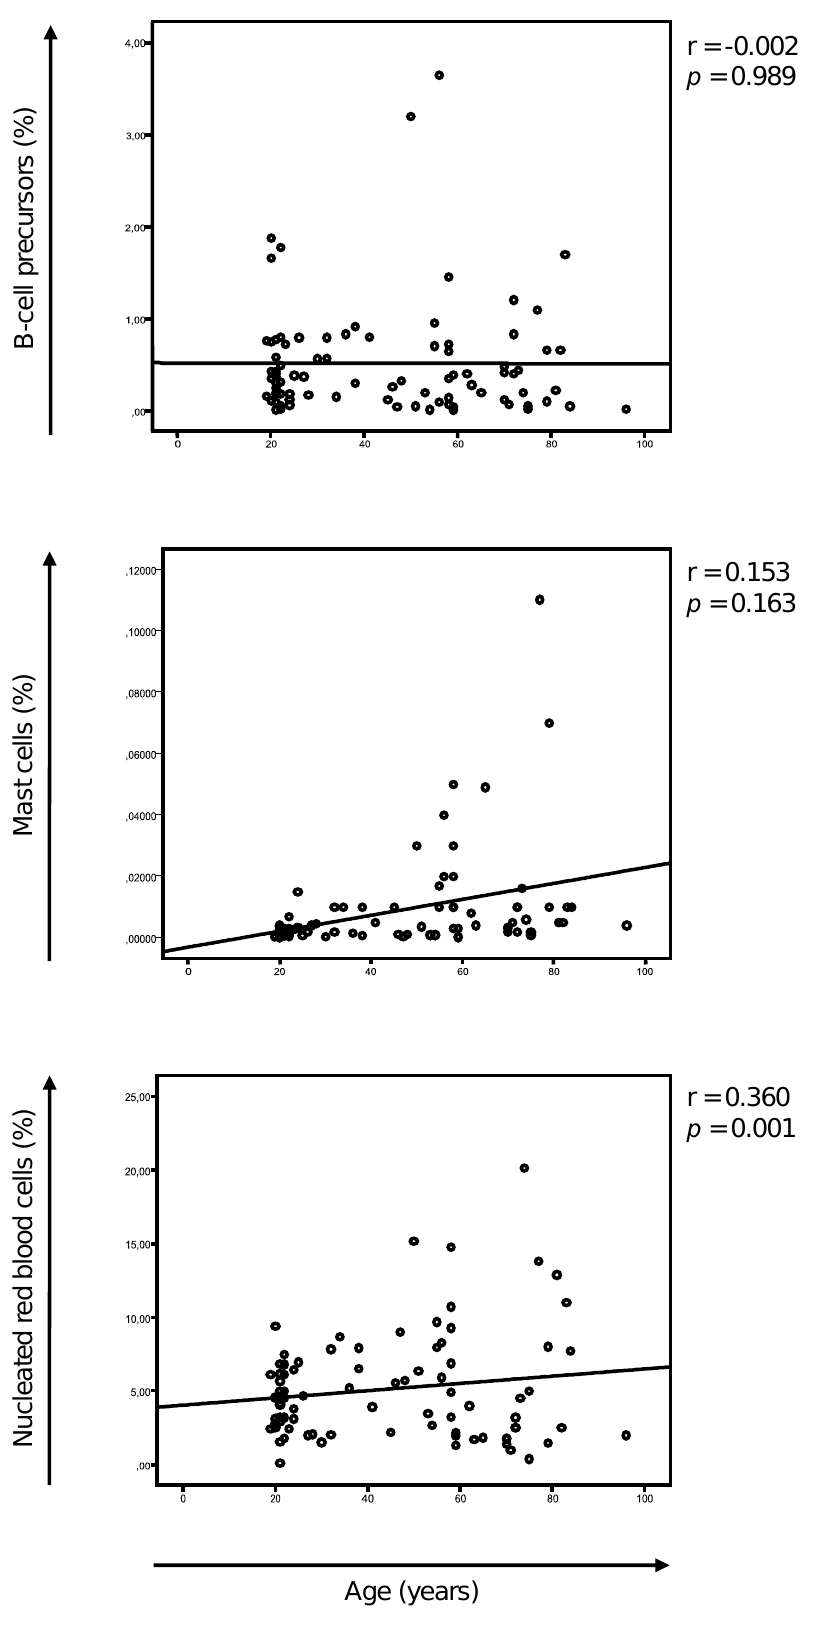
Figure 1. Correlation between age and the percentage of B-cell precursors, mast cells and nucleated red blood cells in bone marrow aspirates from healthy adults ( n = 85).